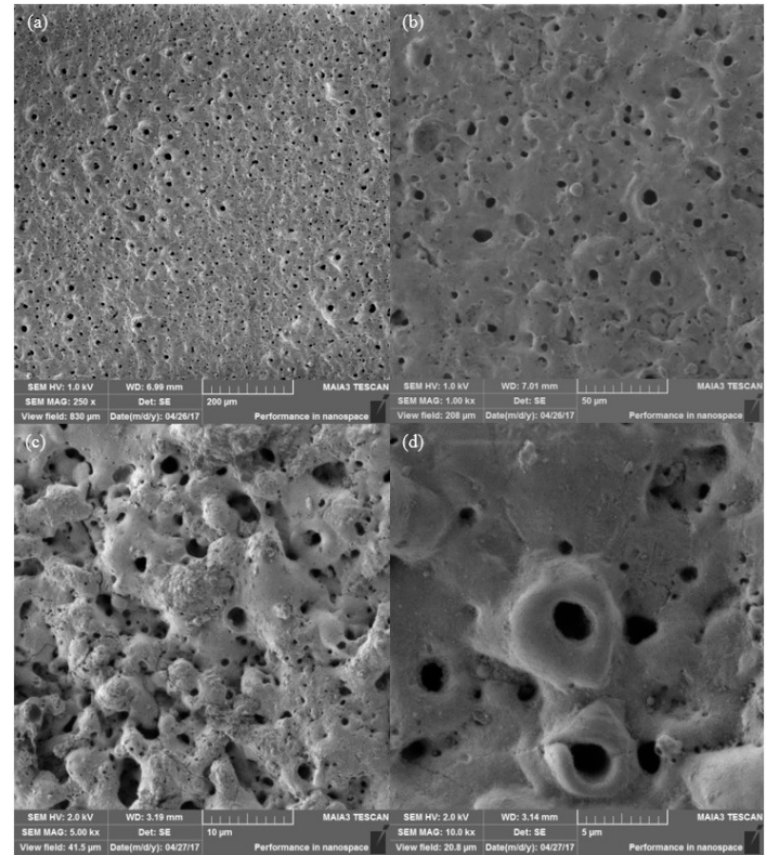
Figure 3. Surface morphology of the Al 1050 alloy after PEO treatment, magnifications: ( a ) 250×; ( b ) 1000×; ( c ) 5000×; ( d ) 10,000×.